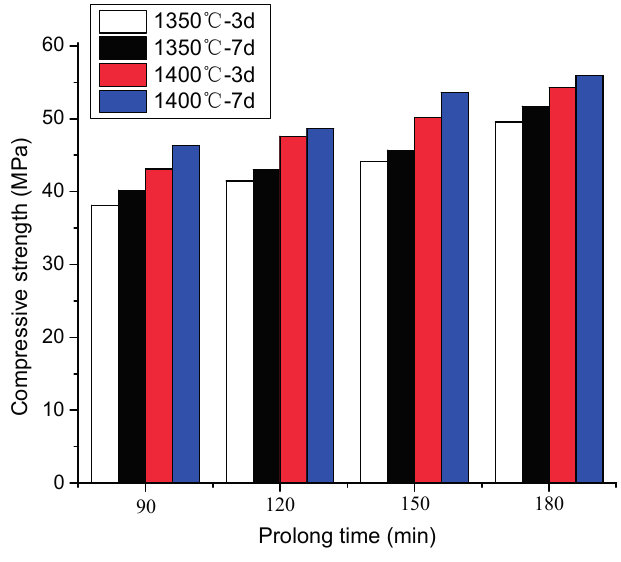
Figure 5. Compressive strength of 1350 °C and 1400 °C sintered